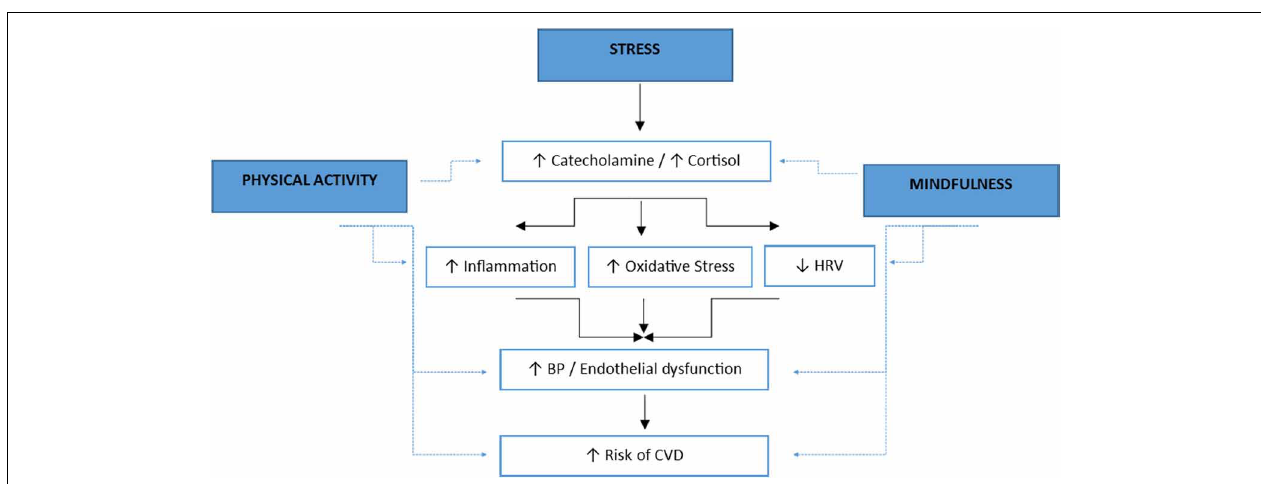
FIGURE 1 | Potential physiological mechanisms shared by physical activity and mindfulness by which they may attenuate cardiovascular responses to stress (the solid line indicates an activation of the